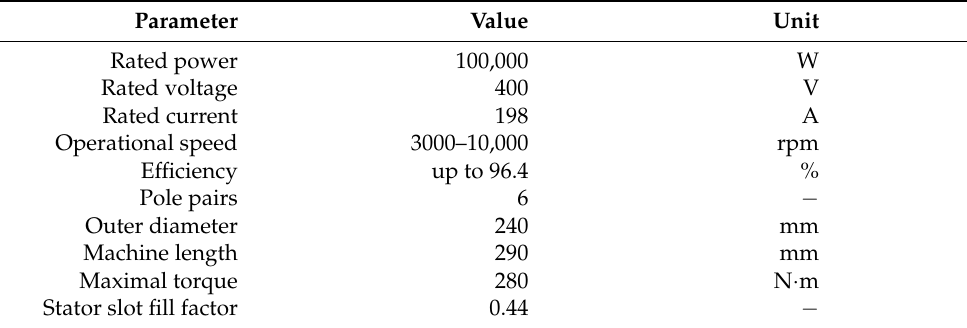
Table 1. Main parameters of the measured